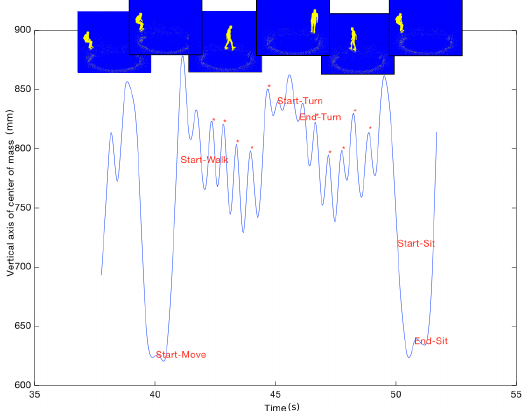
Figure 2. Trajectory of the centroid of a participant and automatic detection of six events.